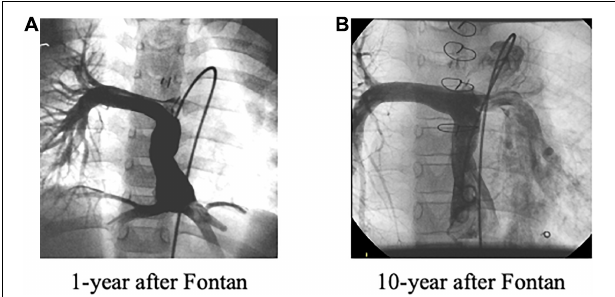
FIGURE 4 | (A) Unbalanced pulmonary artery flow distribution at 1 year after the Fontan operation. (B) Improved unbalanced, i.e., “balanced,” pulmonary artery flow distribution was observed at 10 years after the Fontan operation due to significantly increased left pulmonary flow.